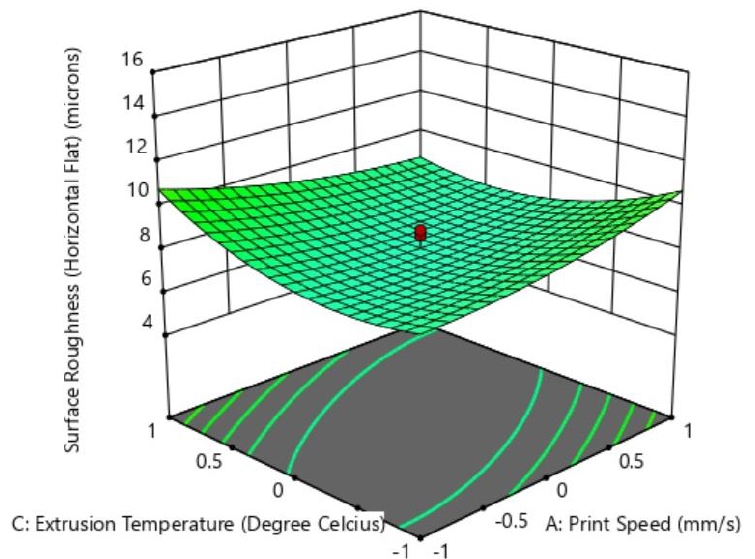
Figure 12. Combined effect of print speed and extrusion temperature on surface roughness for the flat profile.